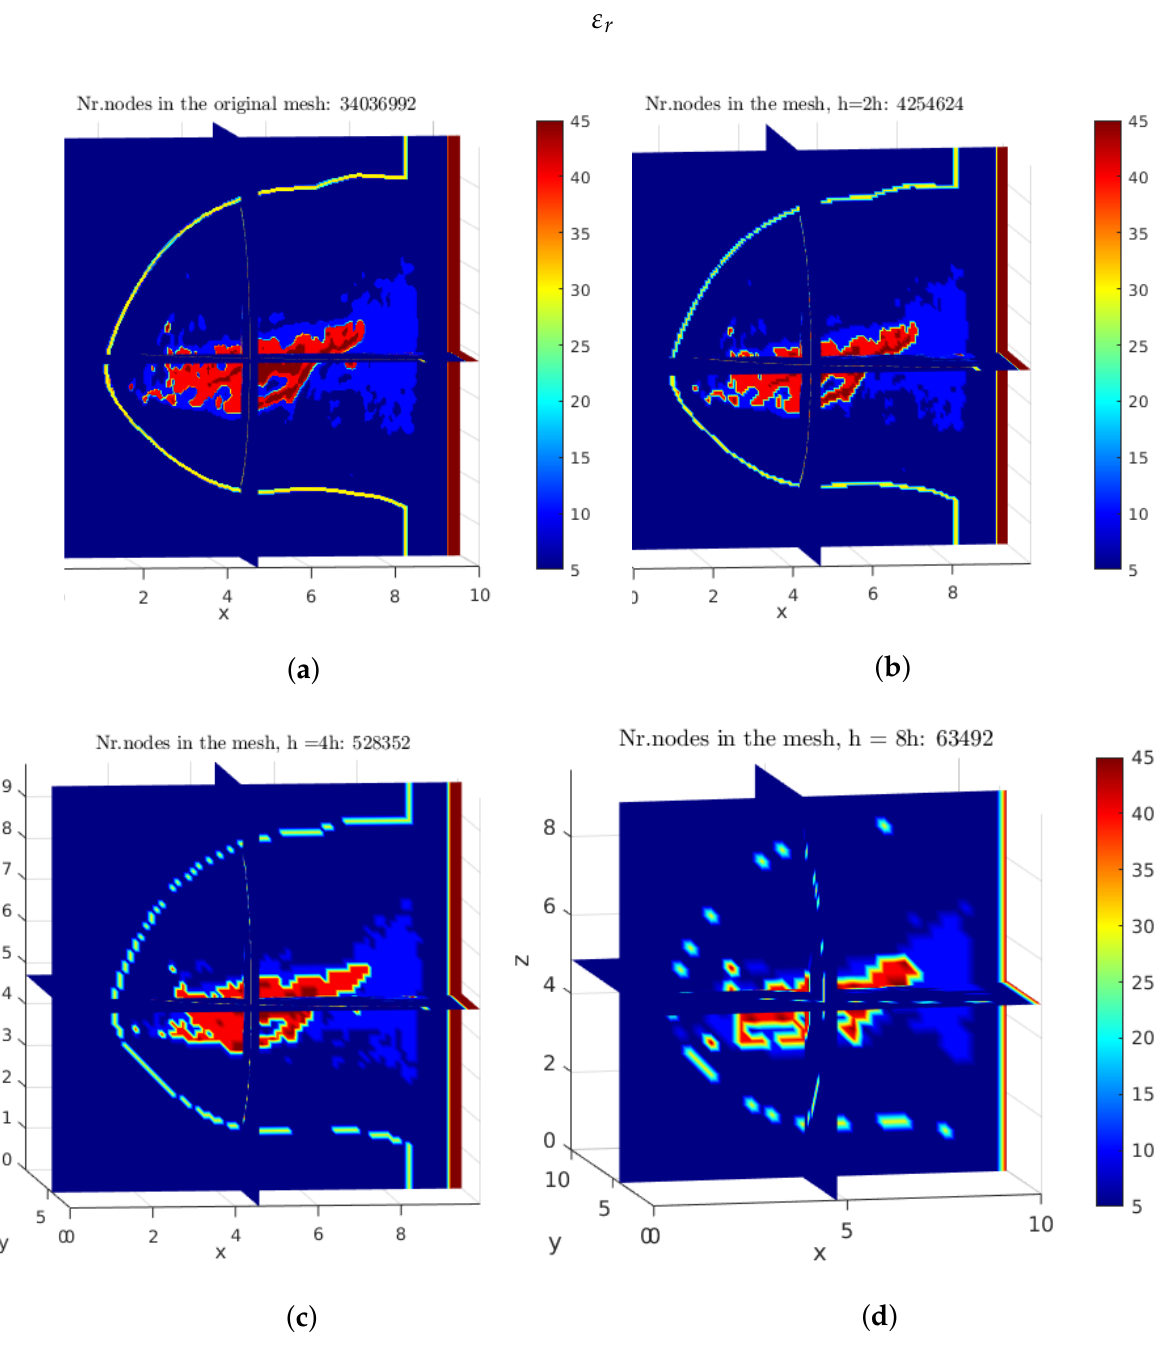
Figure 4. Spatial distribution of realistic ultrawideband dielectric properties of 3D breast phantom